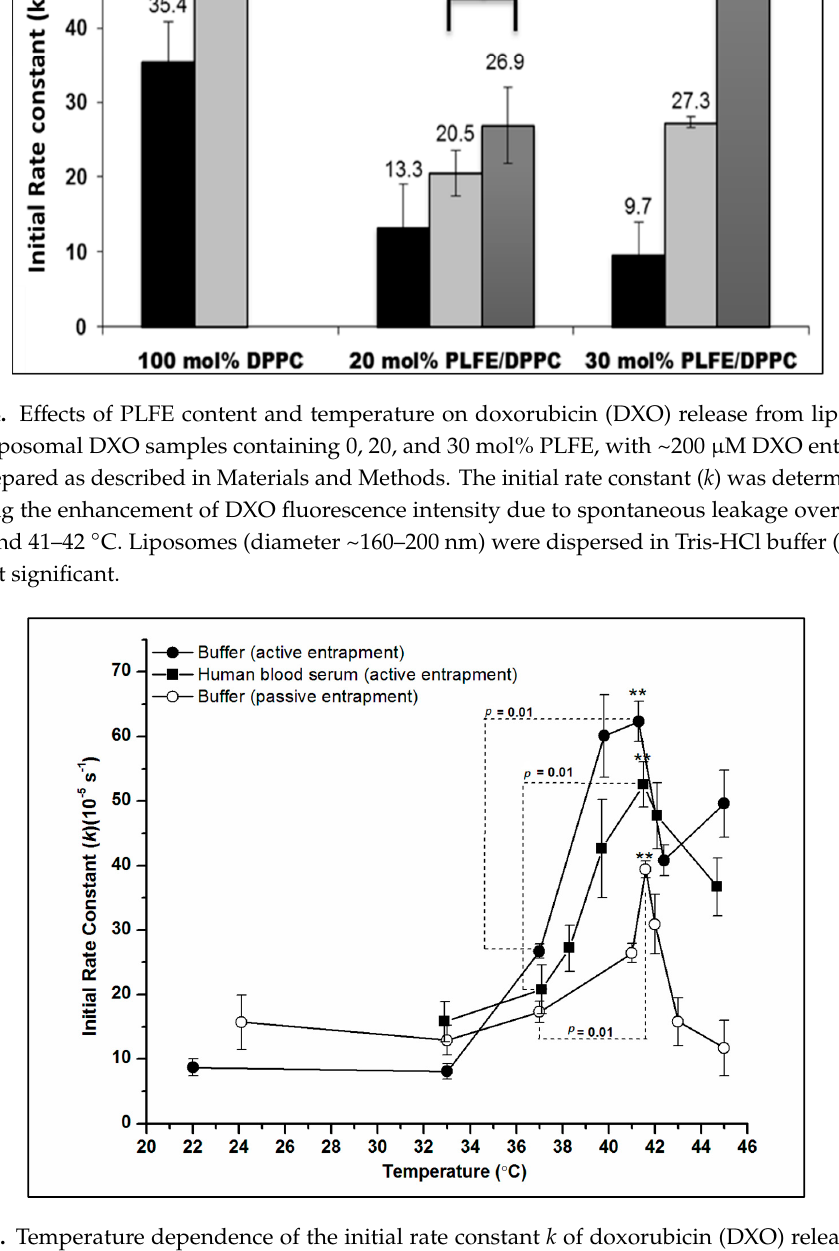
Figure 5. Temperature dependence of the initial rate constant k of doxorubicin (DXO) release from PLFE/DPPC(3:7) archaeosomes. Archaeosomes were dispersed either in 50 mM Tris-HCl buffer (pH 7.2) containing 10 mM EDTA and 0.02% of NaN3 or in 50% human blood serum prepared in 10 mM HEPES buffered saline (HBS) containing 145 mM NaCl, 5 mM KCl, 0.1g/L glucose, and 0.1 g/L bovine serum albumin (BSA; pH 7.5). DXO was loaded into liposomes by the active or passive entrapment method as indicated. The p values were determined from three samples ( n = 3).